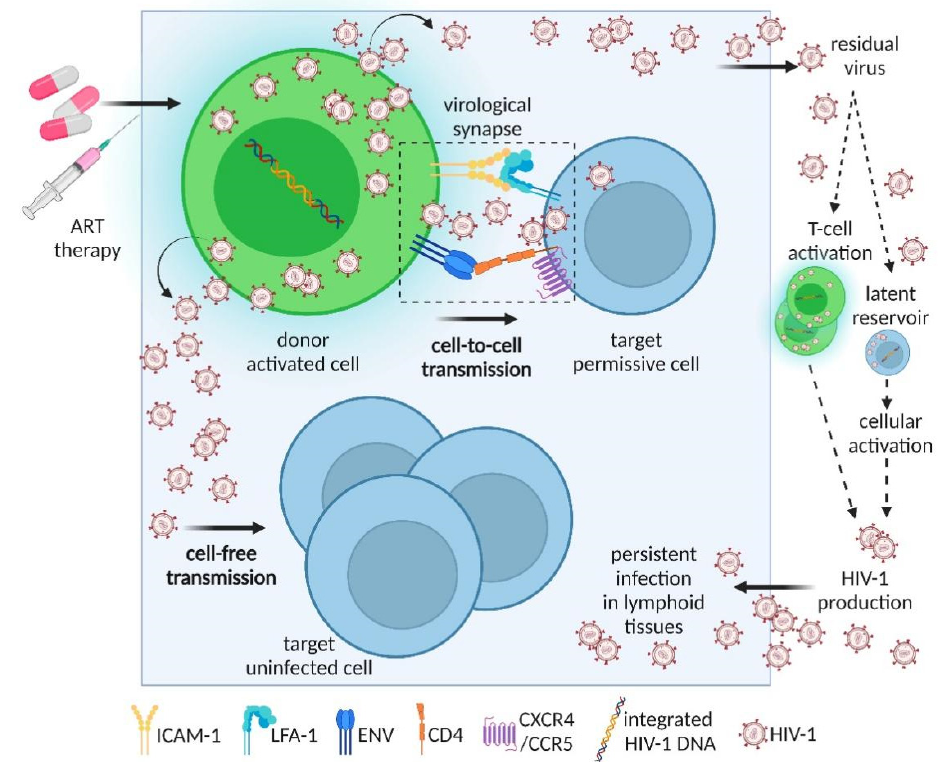
Figure 1. Overview of current models of HIV-1 transmission between CD4 + T cells.